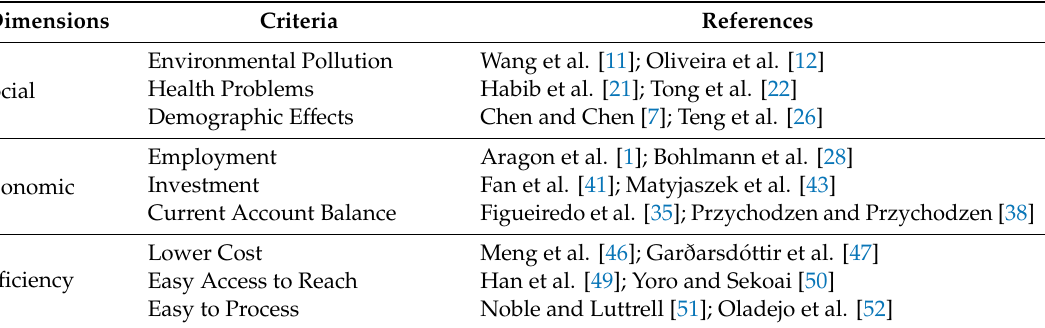
Table 1. The dimensions and criteria for the evaluation of coal